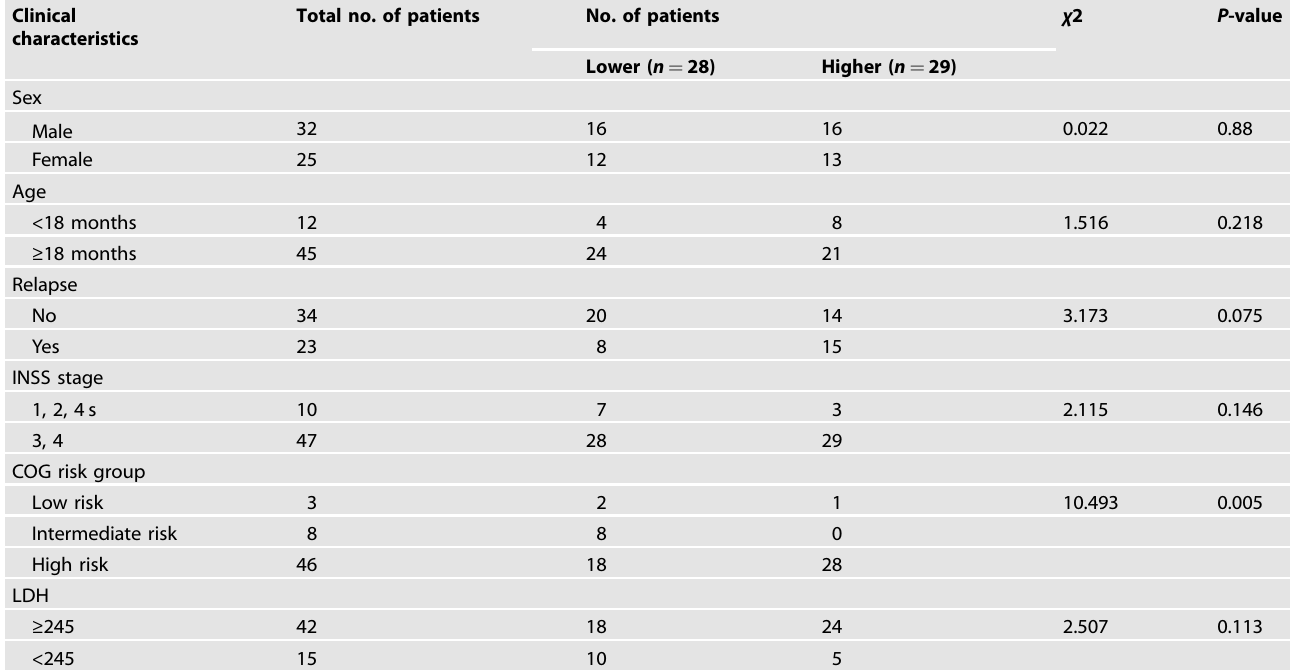
Table 1. The relationship between ISL1 expression and clinical – pathological features in 57 NB patients from our department. Clinical